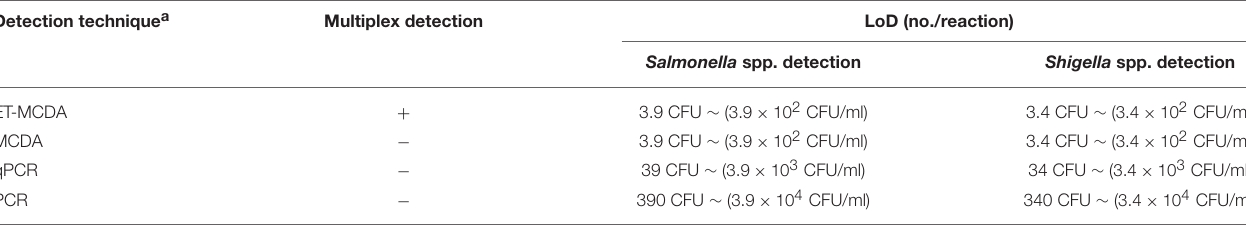
TABLE 4 | Comparison of ET-MCDA, MCDA, qPCR, and PCR technique for detection of Salmonella spp. and Shigella spp. in artificially contaminated blood samples. Detection technique a Multiplex detection LoD (no./reaction) Salmonella spp. detection Shigella spp.